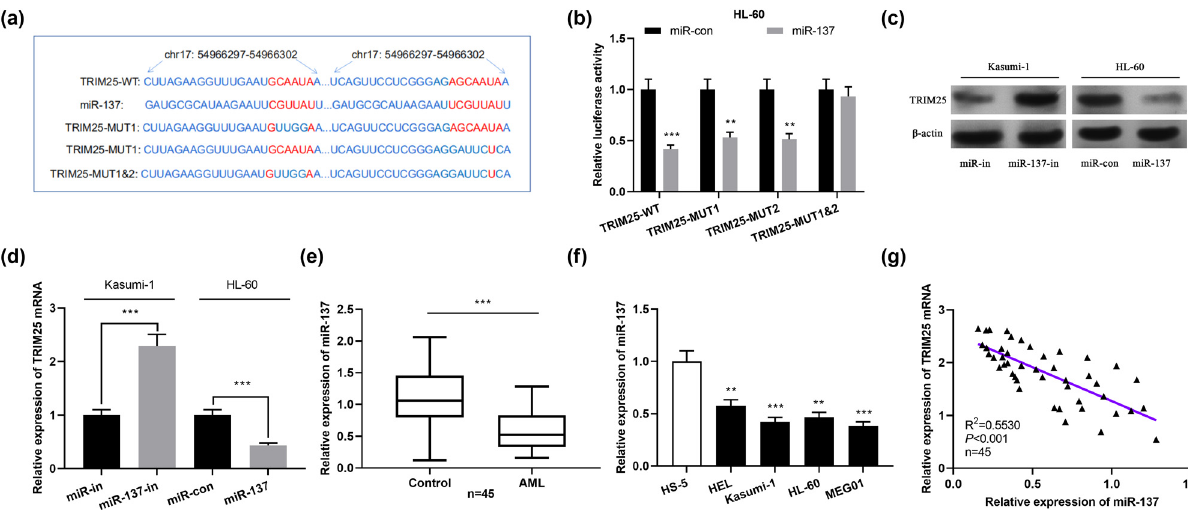
Figure 3: TRIM25 was the target of miR - 137. ( a ) Bioinformatics analysis predicted the binding sequence of miR - 137 and TRIM25. ( b ) Dual - luciferase reporter experiment to analyze the binding relationship between miR - 137 and TRIM25. ( c and d ) Western blot and qPCR to detect the e ff ect of knockdown or overexpression of miR - 137 on TRIM25 protein and mRNA expression. ( e and f ) qPCR to detect miR - 137 expression in AML samples and cells. ( g ) qPCR to evaluate the correlation between miR - 137 and TRIM25 mRNA expression in AML samples. ** P < 0.01, *** P <